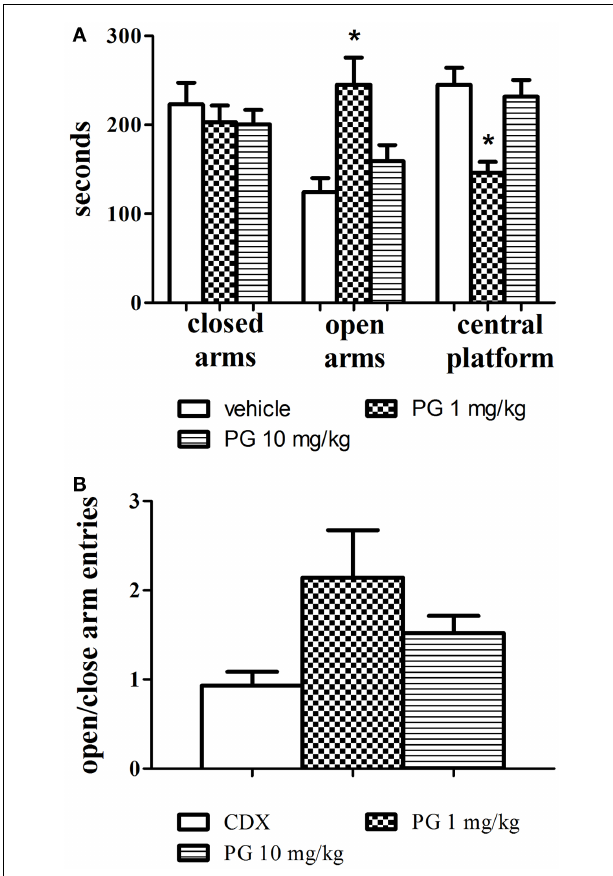
FIGURE 2 |Anxiolytic effect of PG was assessed in an elevated plus maze . (A) PG administered at the dose of 1mg/kg significantly increased the time spent in the open arms, and decreased the time spent in the central platform. Mice treated with PG at the dose of 10mg/kg did not display anxiolytic behavior. All values represent group means ± SEM. * p < 0.005 compared to the vehicle, β -CD group. (B) The analysis of open to close arm entries did not reveal differences between treatment groups, probably due to big differences in variance within each group. All values represent group means ± SEM.